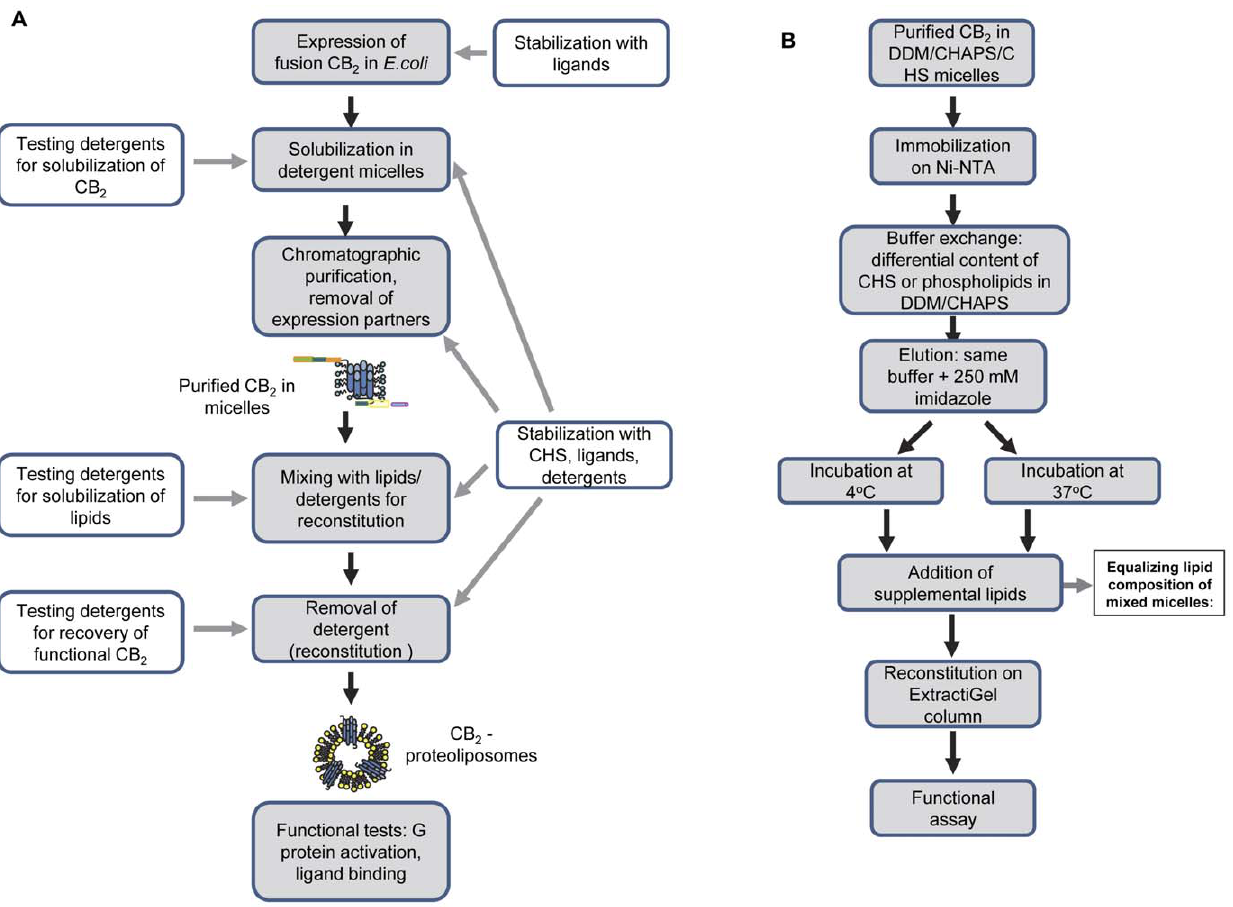
N Efficient solubilization of the fusion N Optimization of the